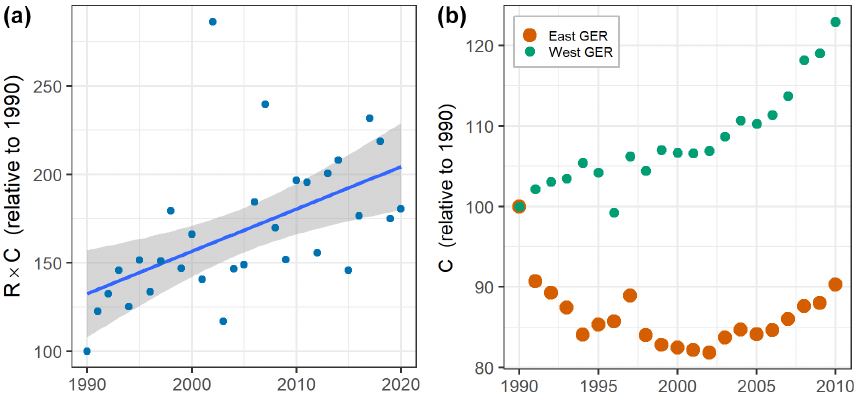
Figure 9. Change in erosion as quantified by the Universal Soil Loss Equation relative to erosion in 1990. (a) Combined influence of rain erosivity ( R factor) and land use ( C factor). (b) Influence of land use and management in West and East Germany upon C